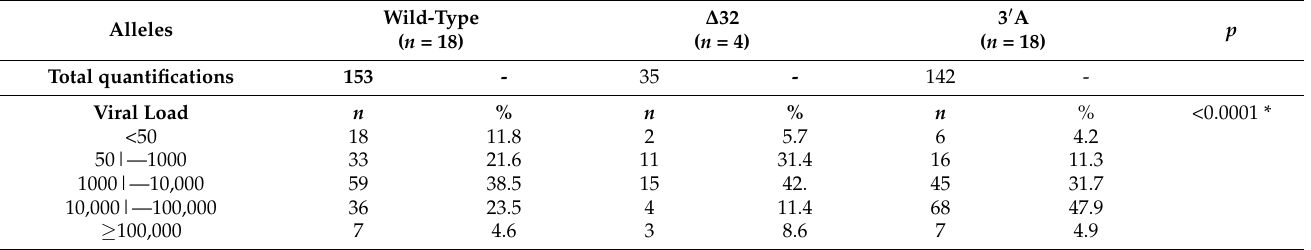
Table 3. Plasma viral load of HIV-1 according to the presence of variant alleles of CCR5 and SDF1 3 (cid:48) A.